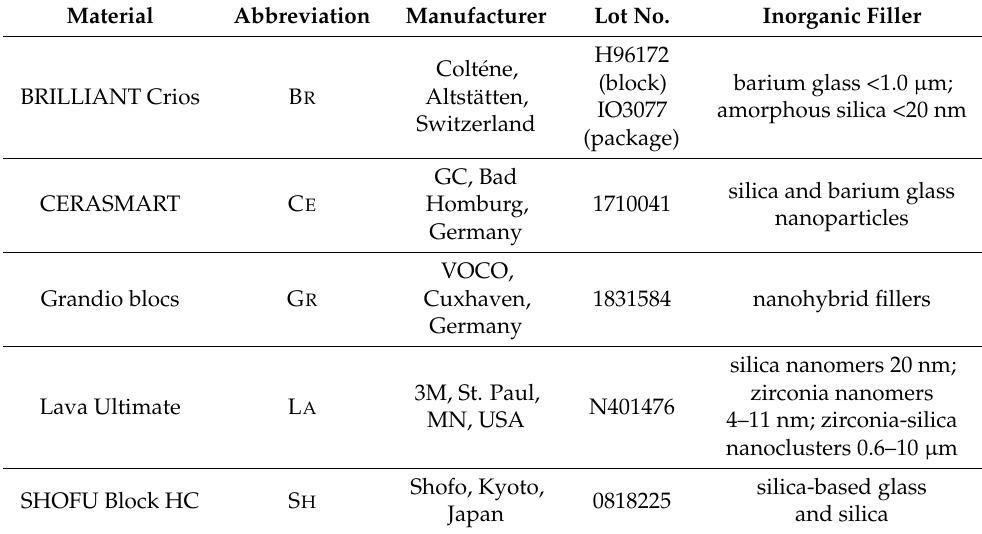
Table 1. CAD/CAM composites used in this study and composition of the inorganic fillers [12,17].